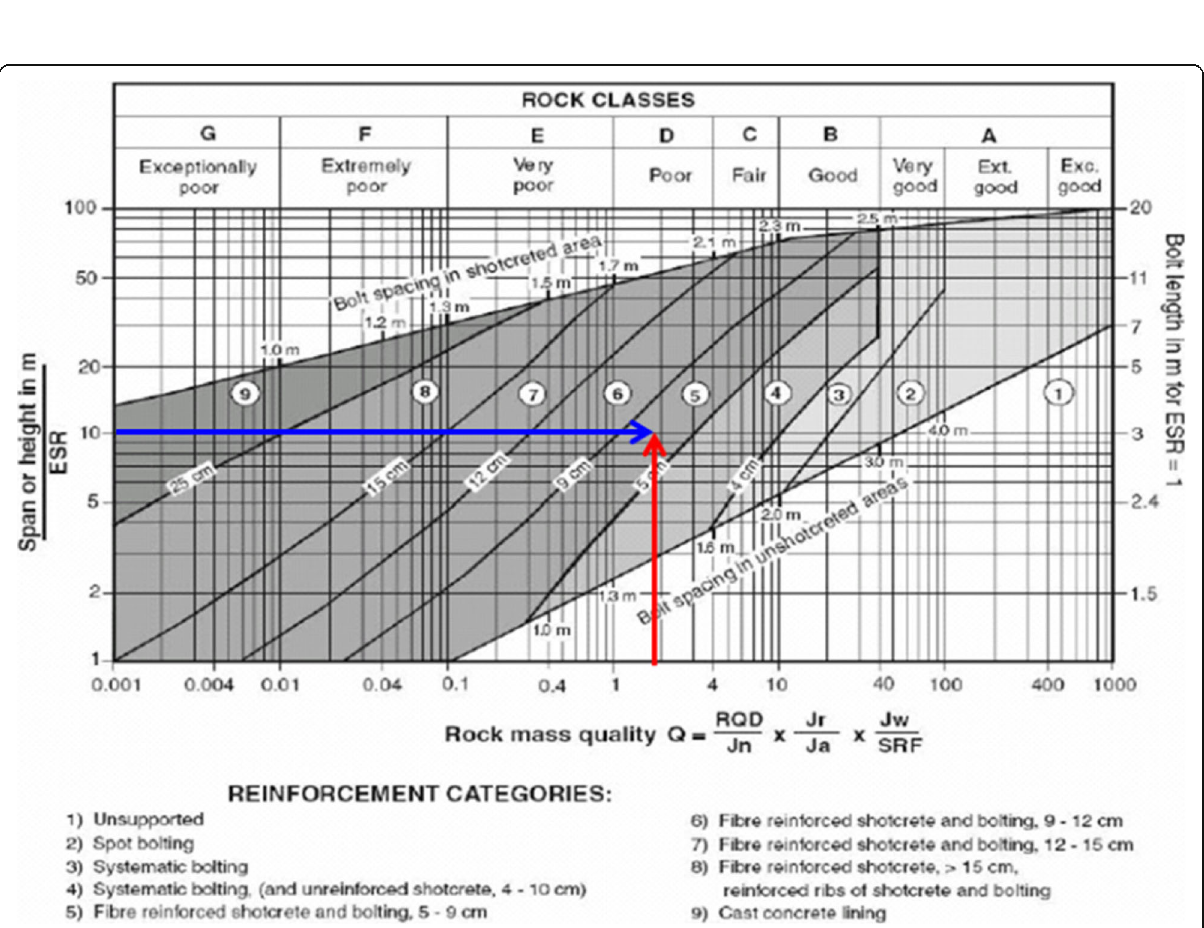
Fig. 28 Proposal support system for the (KV5) according to the Barton ’ s